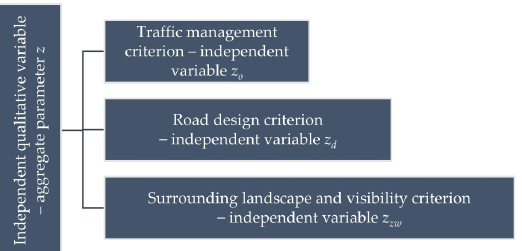
Figure 5. Proposed scheme for determining the aggregate parameter z with a division to the three adopted criteria.